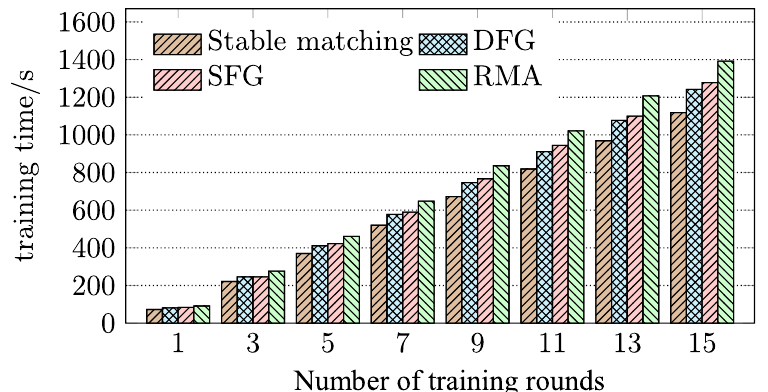
Figure 6. Model training time with different